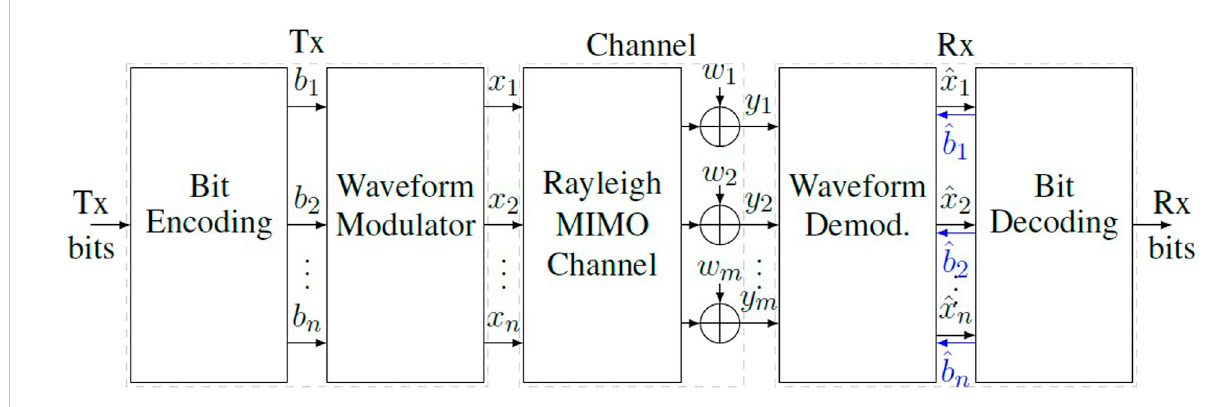
FIGURE 1 Simpli fi ed block diagram of a generic and communication system.